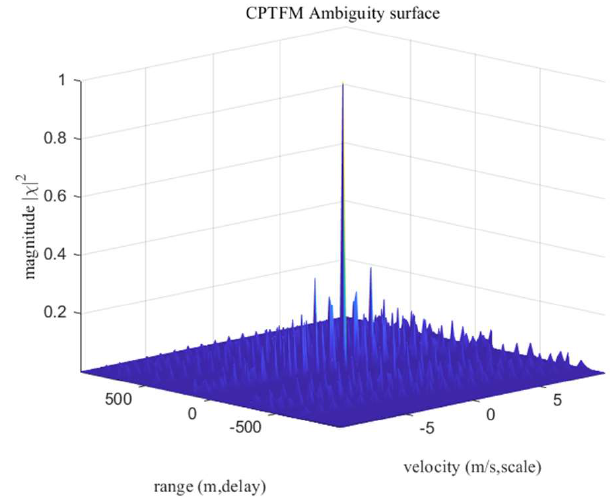
Figure 5. Ambiguity surface of the CPTFM waveform in this article.